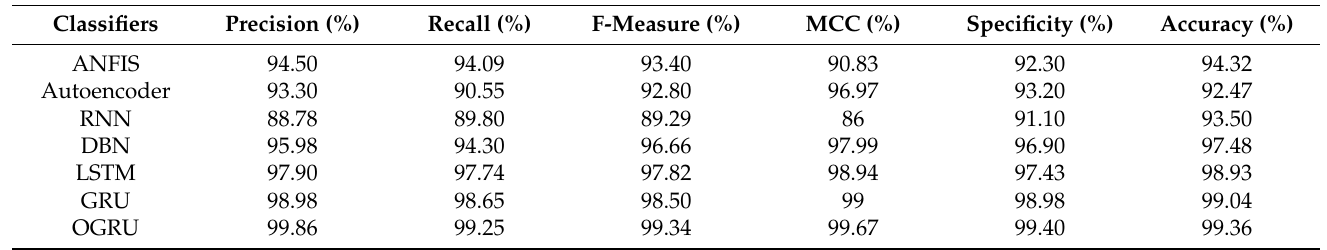
Table 1. Simulation results of the proposed model by varying the classifiers with 50:50% training Table 2. Simulation results of the proposed model by varying the classifiers with 80:20% training and and testing of data. testing of data. CSO Algorithm with 80% Training and 20% Testing of Data